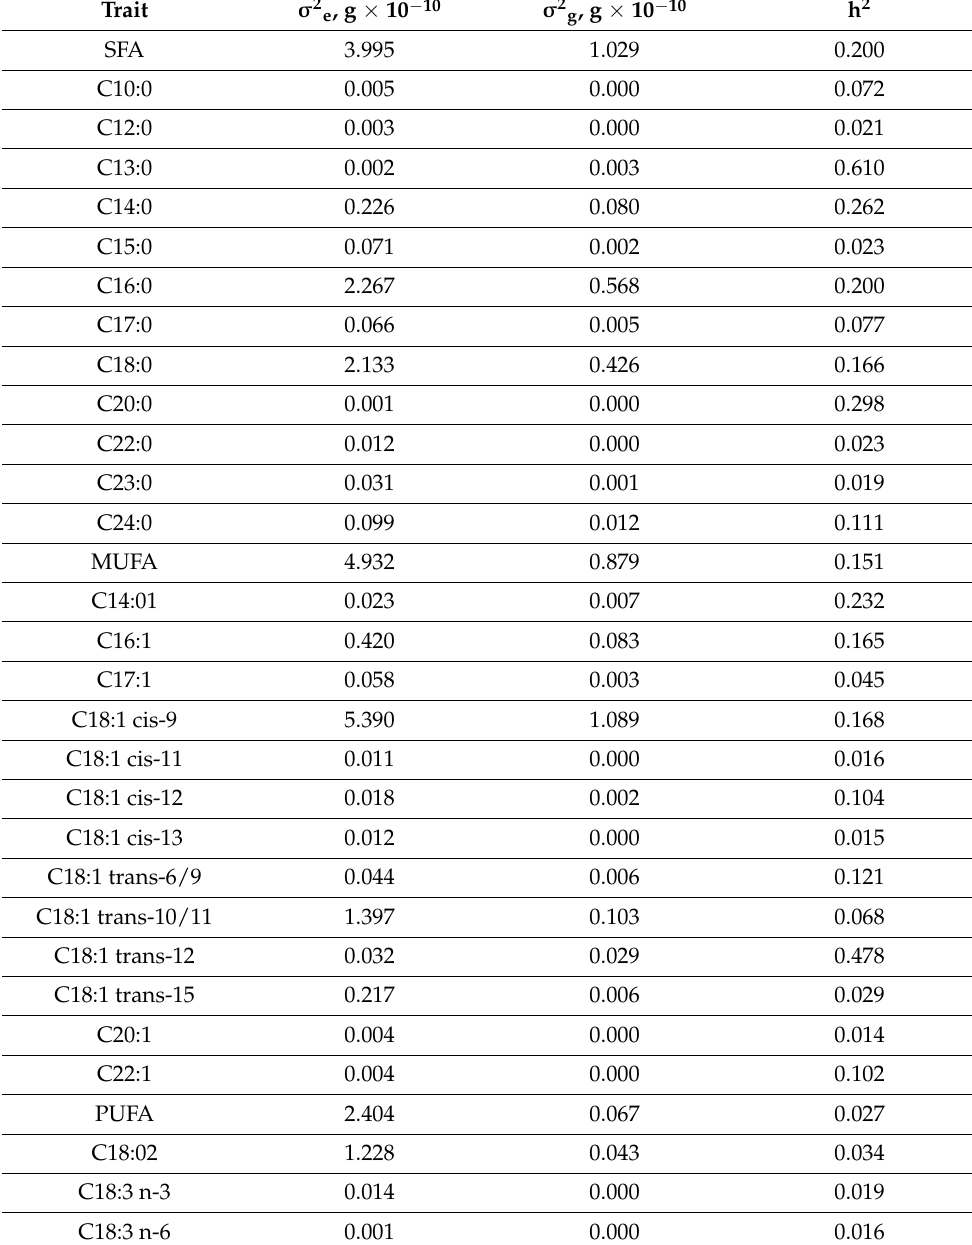
Table 2. Posterior residual variance ( σ 2 e , g × 10 − 10 ) estimate, genetic variance ( σ 2 g , g × 10 − 10 ) estimate and the estimated heritability (h 2 ) for fatty acids (Fat% basis).